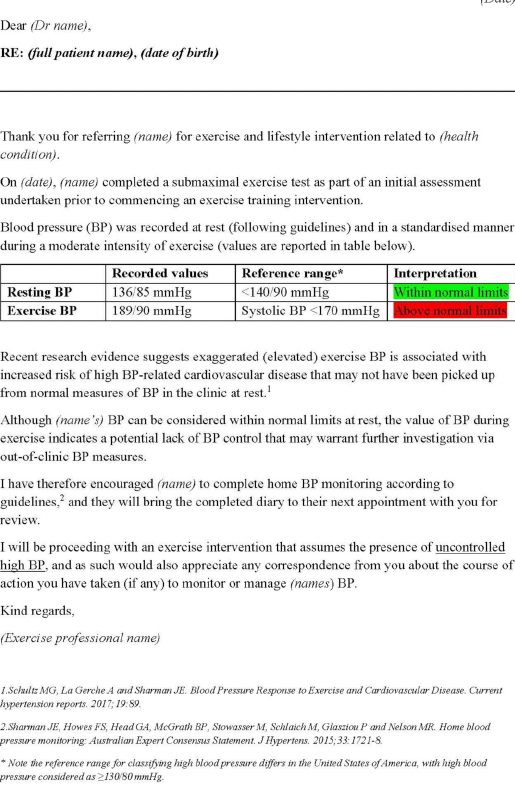
Figure 3. Example correspondence from an exercise professional to a primary care physician outlining findings related to exaggerated exercise blood pressure signalling uncontrolled high